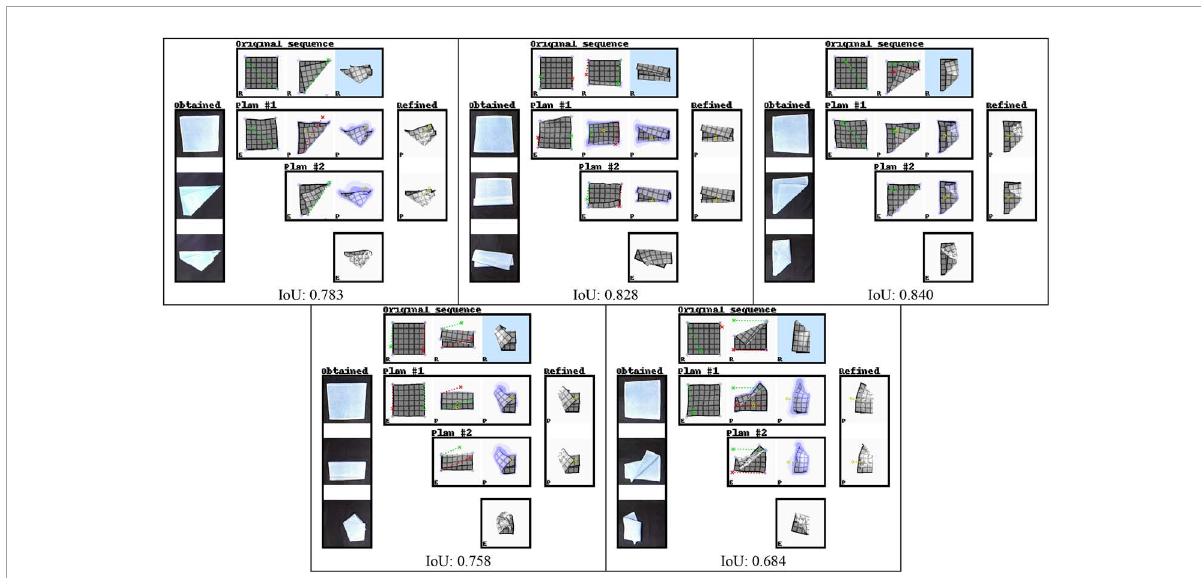
FIGURE10 Two-step manipulation sequences planned by the system, performed by a dual-handed robot on real cloth. See Figure 9 for the figure format. The right-most column in each example shows the sequence of actually obtained physical cloth shapes. Input states for plan generation are obtained by shape estimation on voxelised point cloud data of the real cloth. Real cloth shapes are captured at a slight angle due to the camera placement. Plans were rotated by multiples of 90 ◦ degrees around the z-axis in order to accommodate limitations of the robot’s range, and images of real cloth shapes are rotated accordingly. Scores are Intersection-over-Union scores over mask images computed for the goal and outcome, indicating the similarity of the top-down silhouettes of goal and outcome shapes, with 1.0 corresponding to a perfect